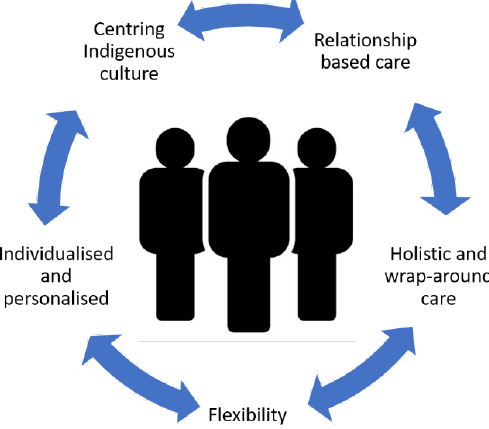
Figure 1. Features of value of the ESF